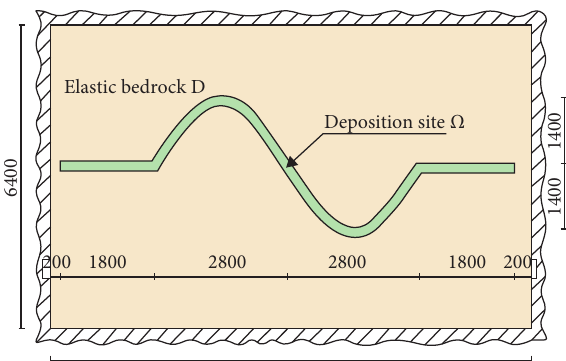
Figure 5: The XY plane of two meandering river